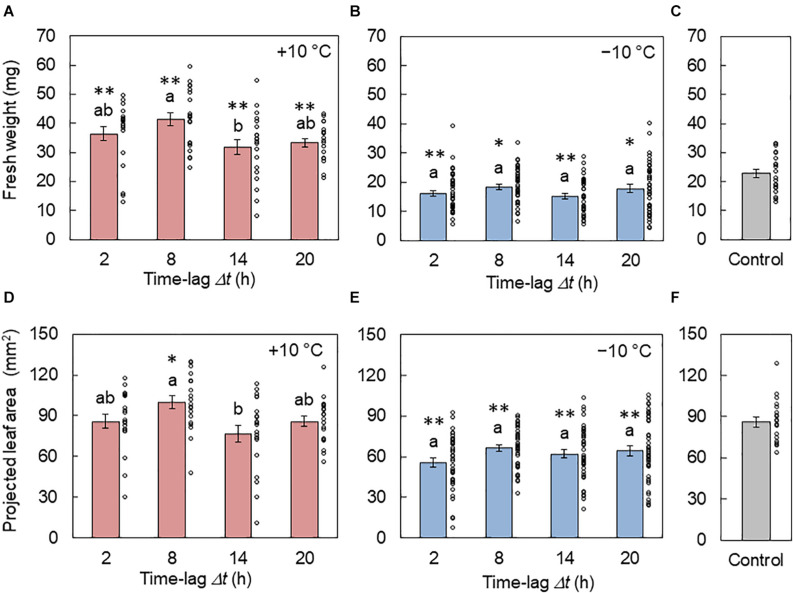
Effect of the time lag on plant growth in conditions of L/D= 16/8 h and 4 h ± 10°C cycles. (A–C) Fresh weights of the areal part from the +10°C (A), −10°C (B), and control (C) conditions (mean ± SEM, n = 20 individuals in (A) and (C) and 40 in (B)). (D–F) Projected leaf areas from the +10°C (D), −10°C (E), and control (F) conditions (mean ± SEM, n = 20 individuals in (D) and (F) and 40 in (E). The circles indicate the individual data points. Two conditions that do not have the same letter indicate significant differences for each panel (Tukey–Kramer test, p < 0.05). Asterisks indicate significant differences with the control condition (Welch’s t-test, *p < 0.05, **p < 0.01).